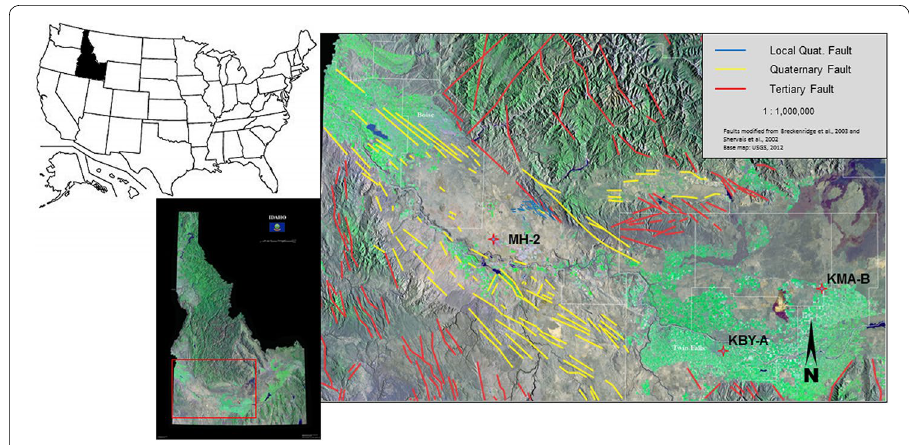
Fig. 1 Locations of Project Hotspot coreholes and regional faults. Green shading represents vegetation, either forests or